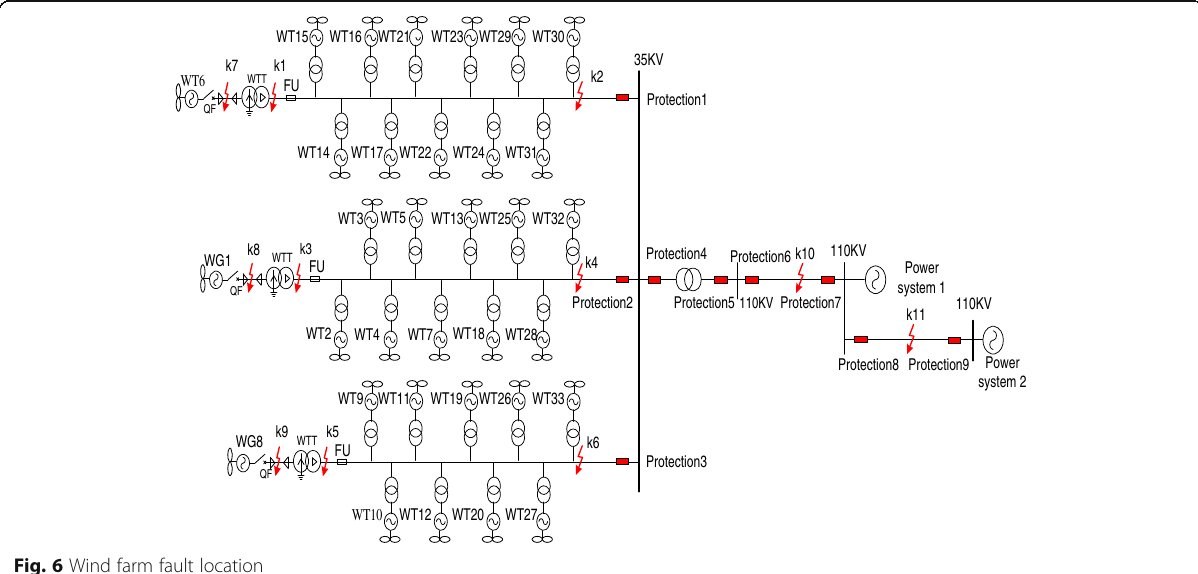
Fig. 6 Wind farm fault